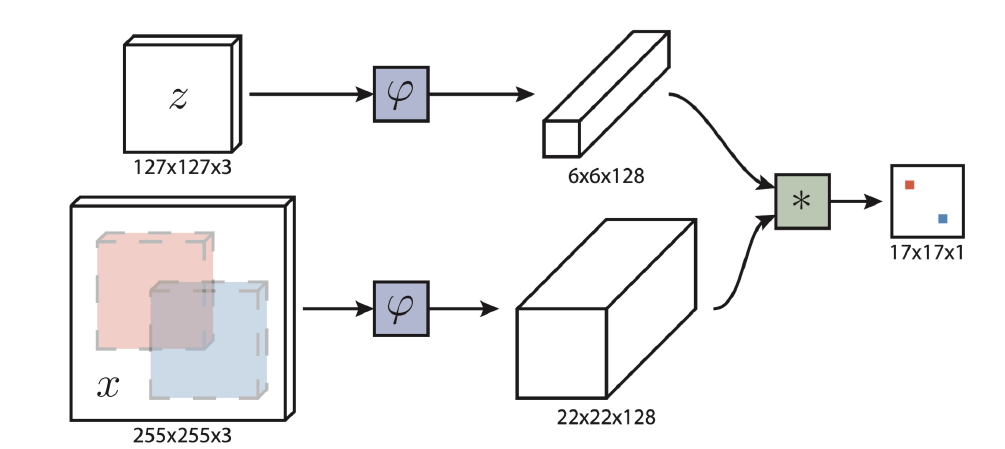
Figure 2. The structure of the SiamFC [19]. The output of the model is a score map. Its dimensions are the same as the size of the search image x . In this case, the score map’s red and blue pixels contain similarities for the corresponding sub-windows. The symbol * indicates the correlation